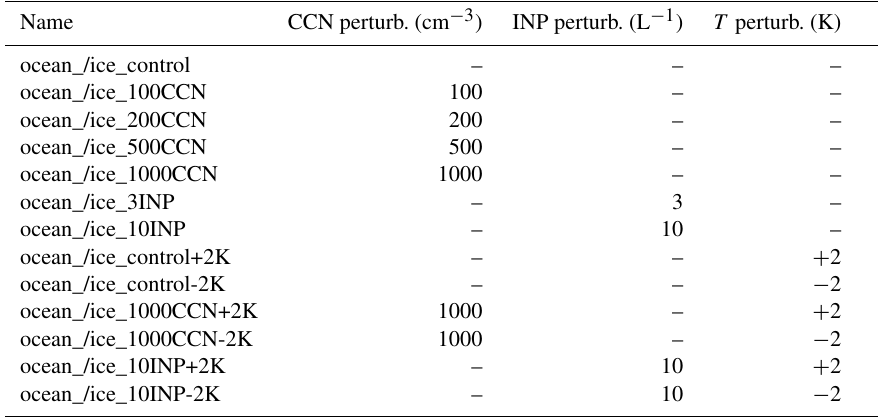
Table 1. Summary of all experiments performed. In all simulations the fixed background CCN concentration is 100cm − 3 and the prognostic INP concentration is set to 3.3INPL − 1 . All settings listed here were run over open ocean and sea ice